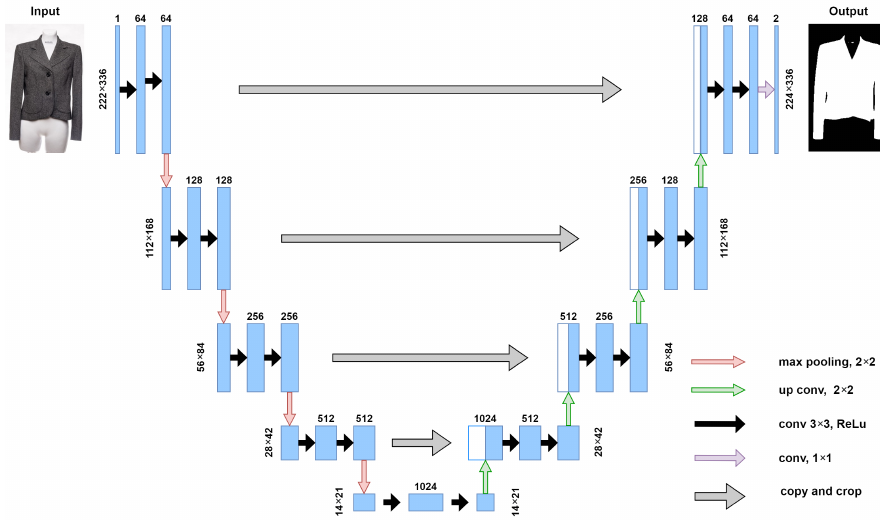
Figure 1. UNet model architecture used for clothes segmentation